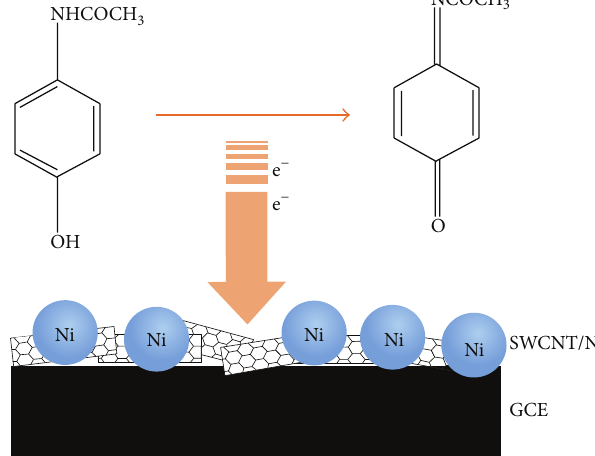
Figure 3: The suggestive scheme for the mediator behavior of SWCNT/Ni nanoparticles in electrocatalytic reaction of paraceta- mol.